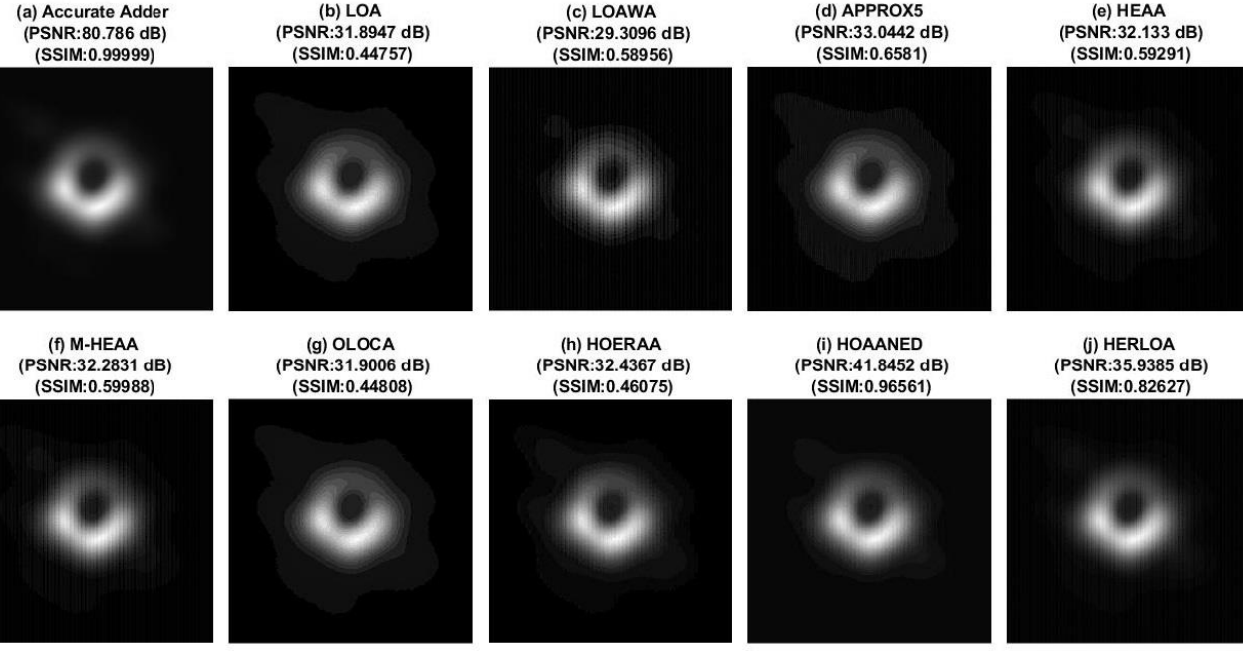
Figure 11. Black Hole image compressed using accurate adder and different approximate adders, with the approximate adders having a 12-bit inexact part. with the approximate adders having a 12-bit inexact